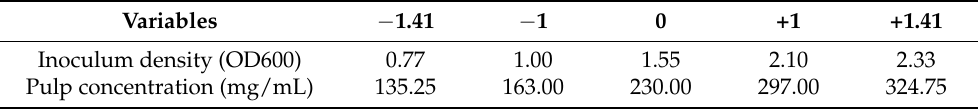
Table 1. Coded and decoded levels of independent